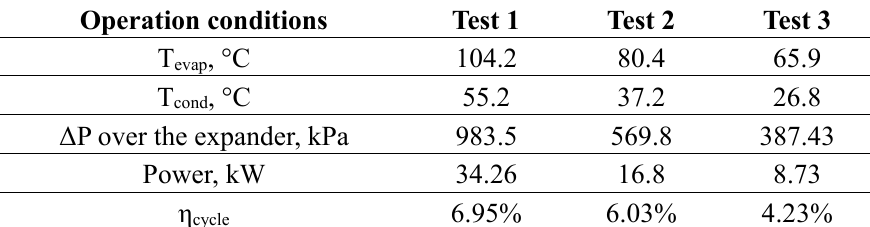
Table 3. Operation conditions for the three tests at system PI ≈